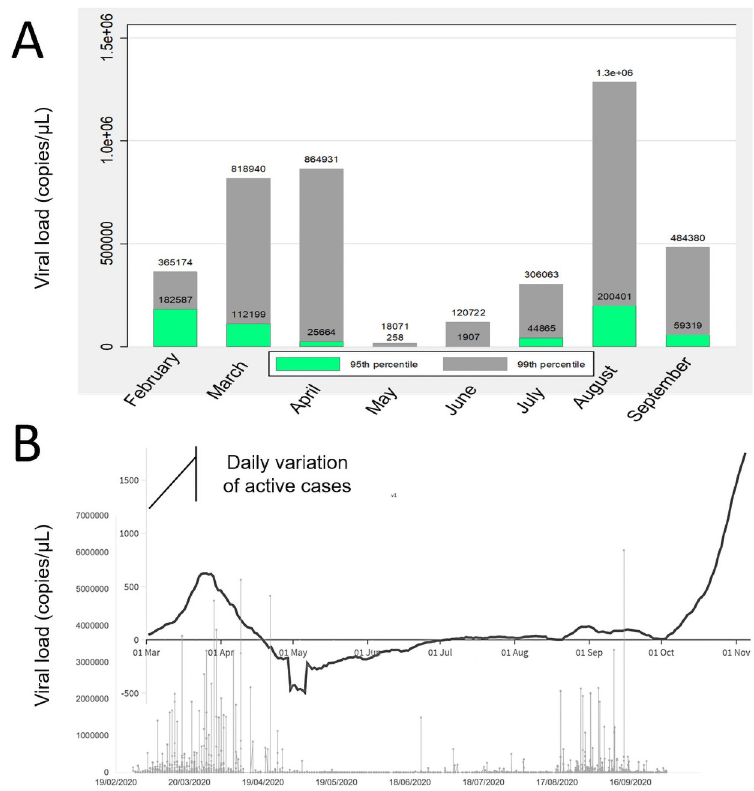
Fig 6. Graph reporting the viral loads (VLs) over time (March 2020 to October 2020) in Italy. A) histograms of the 90 th and 95 th percentiles of calculated VL on a monthly basis. B) Scatter plots of calculated VL (pale grey dots and lines) over the same timescale of fluctuations of active cases (black solid line) expressed as the last daily change (difference with respect to the day before) in active cases (Italian National Ministry of